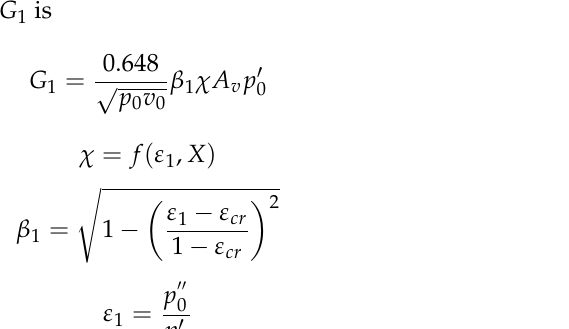
Figure 3. Schematic diagram of the governing valve.